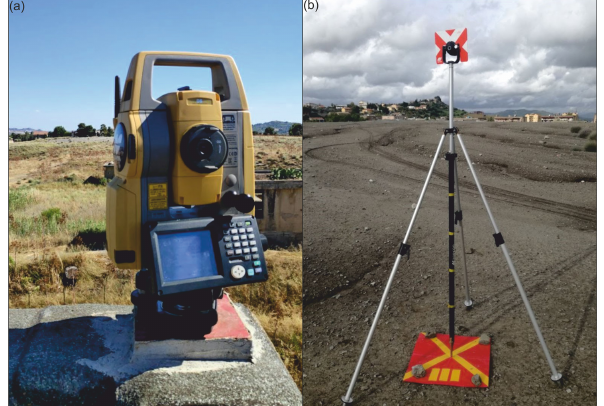
Figure 5. (a) TST DS 103 placed on the fixed metal base in coin- cidence with point CTN0. (b) Surveying ranging rod on the mud volcano during the survey